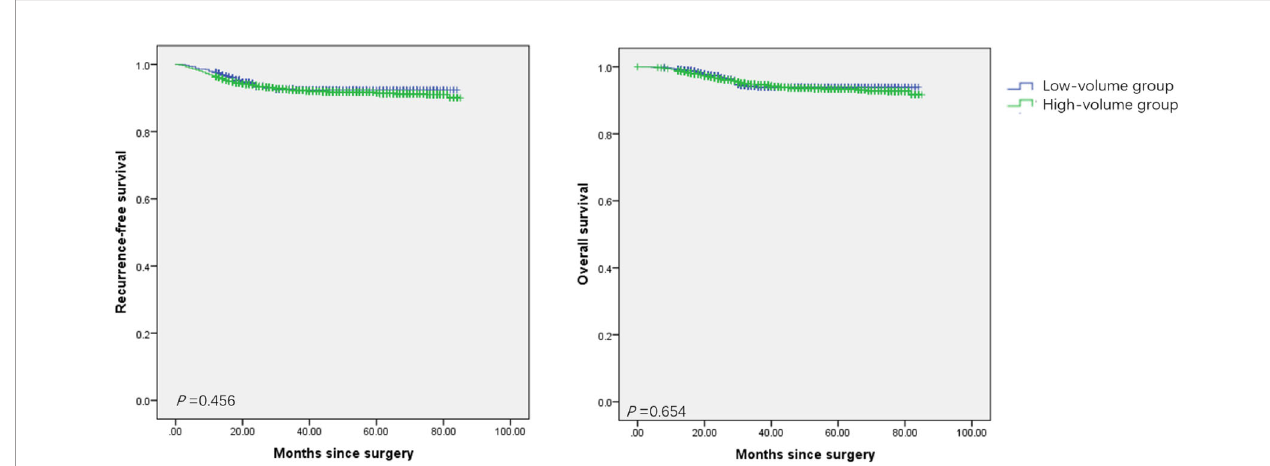
FIGURE 1 | Survival of patients with cervical cancer treated with radical procedures. (A) the Kaplan-Meier estimates of recurrence-free survival between the high- volume group and the low-volume group. (B) the Kaplan-Meier estimates of overall survival between the high-volume group and the low-volume